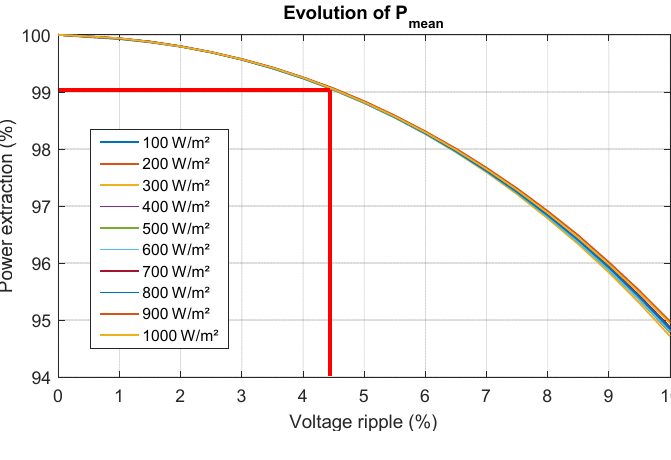
Figure 2. Power drop and voltage ripple [23]. Table 3. Capacitor parameters (TDK aluminum electrolytic,